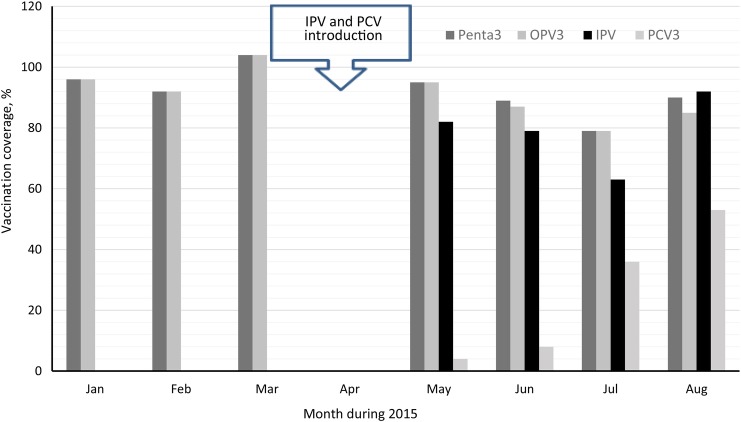
Average vaccination coverage per month for the third doses of pentavalent vaccine (Penta3), oral poliovirus vaccine (OPV3), and pneumococcal conjugate vaccine (PCV3) and for inactivated poliovirus vaccine (IPV) in 23 health facilities, Bangladesh, 2015. Coverage was calculated by dividing the number of children who had received each vaccine dose in a particular month by the number of children who were expected to receive any vaccine per month. IPV and PCV were introduced between 21 March and 11 April in the health facilities assessed. Data from April were not collected.